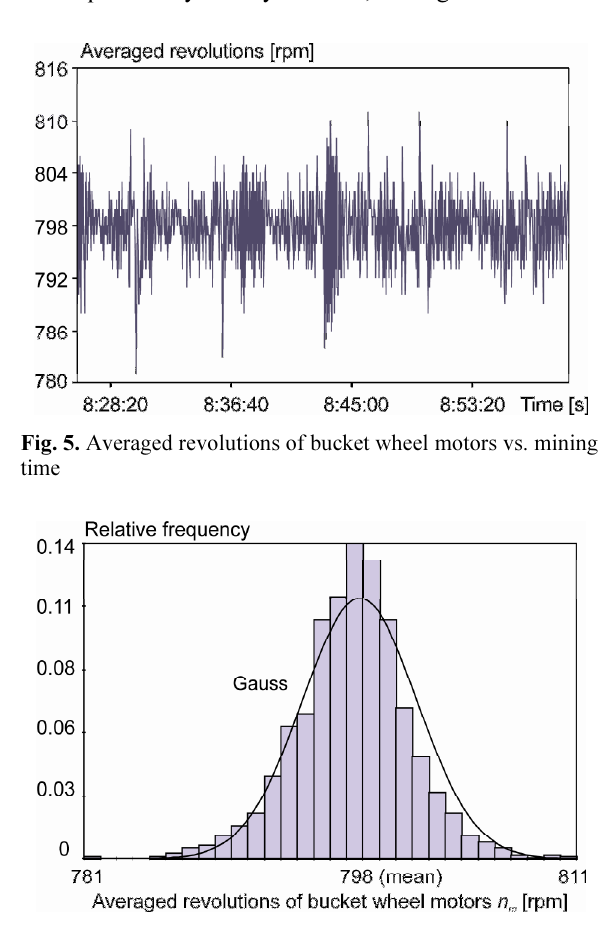
Fig. 7. Total input power of bucket wheel motors vs. mining time